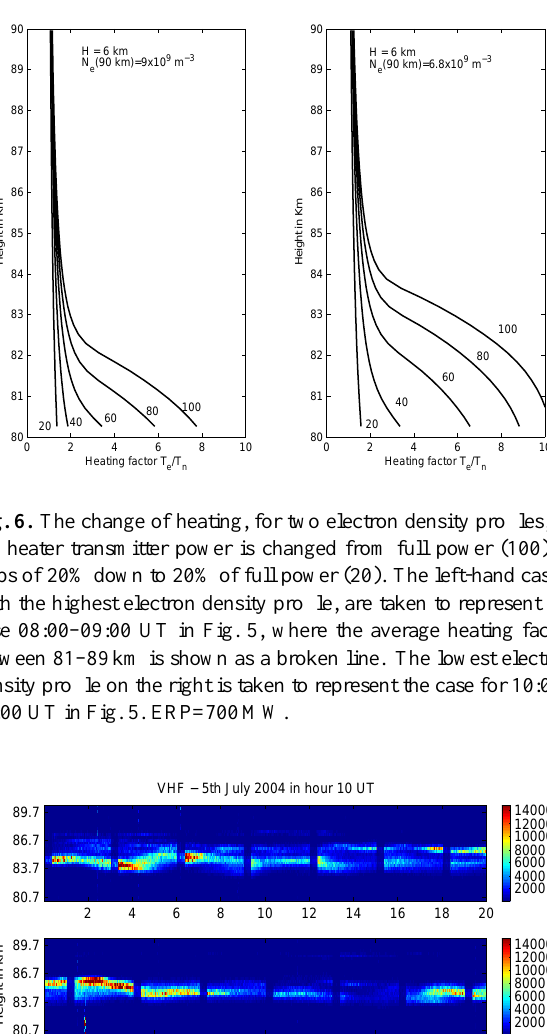
the 2-s sampling just before and after the heater was